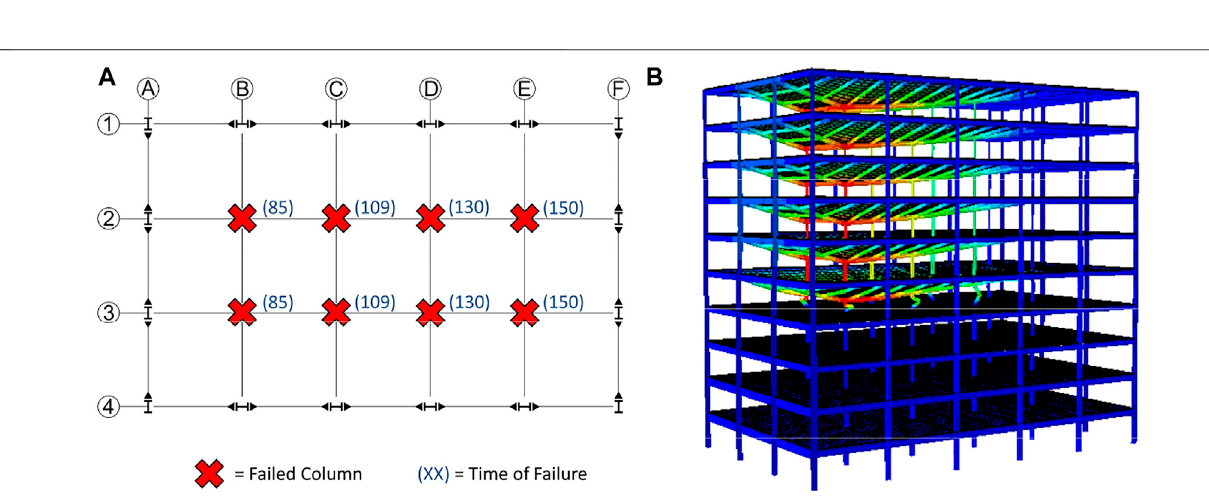
Frontiers in Built Environment |